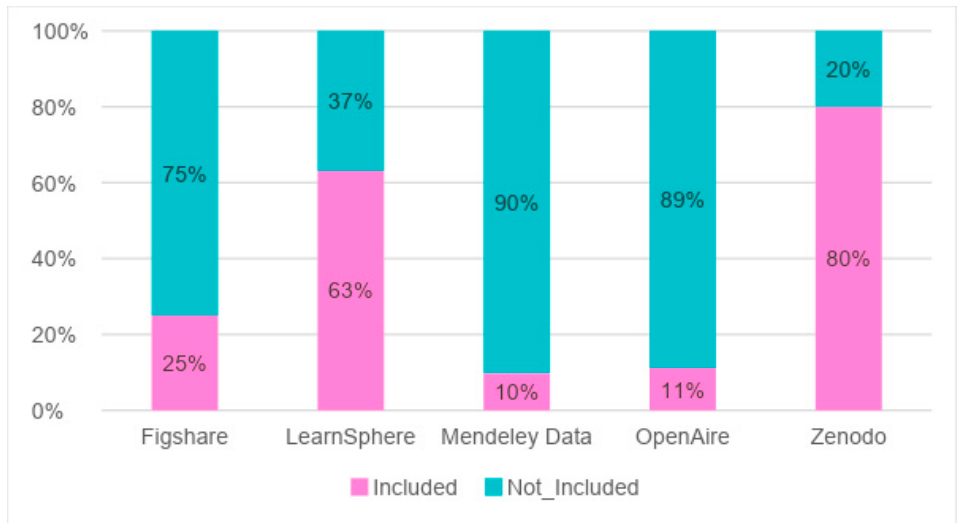
Figure 2. Datasets included and excluded in the five data repositories.